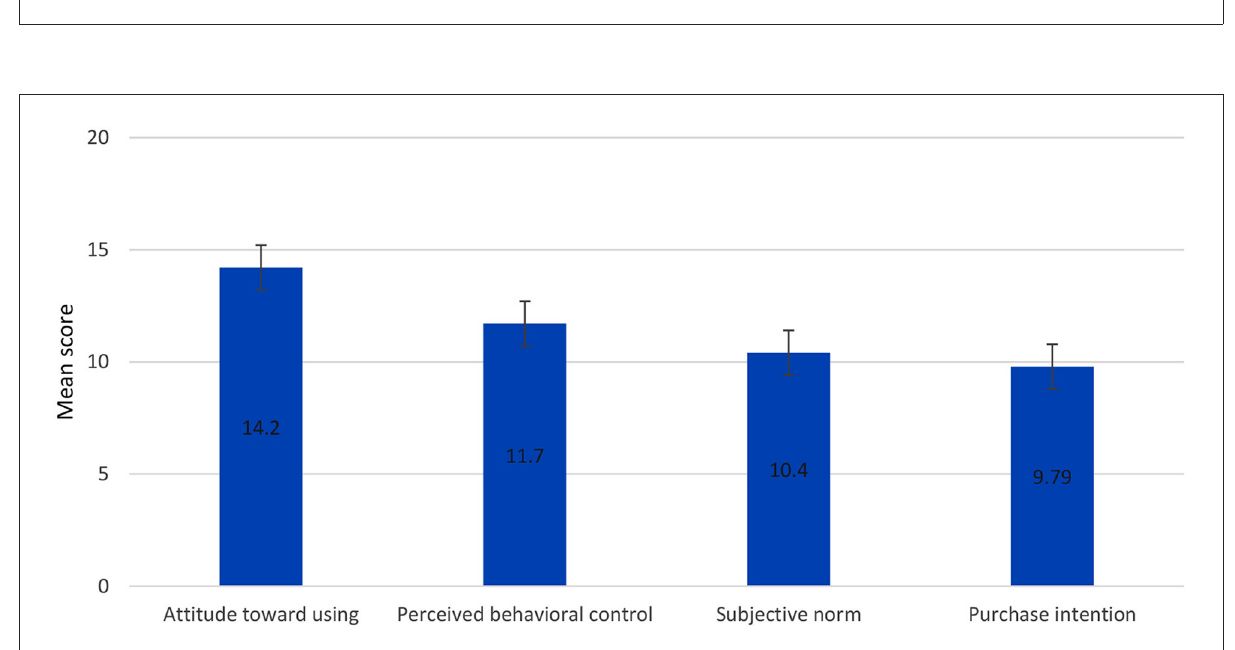
FIGURE3 Explanation for each domain affects the smartwatch user on Saudi Arabia.